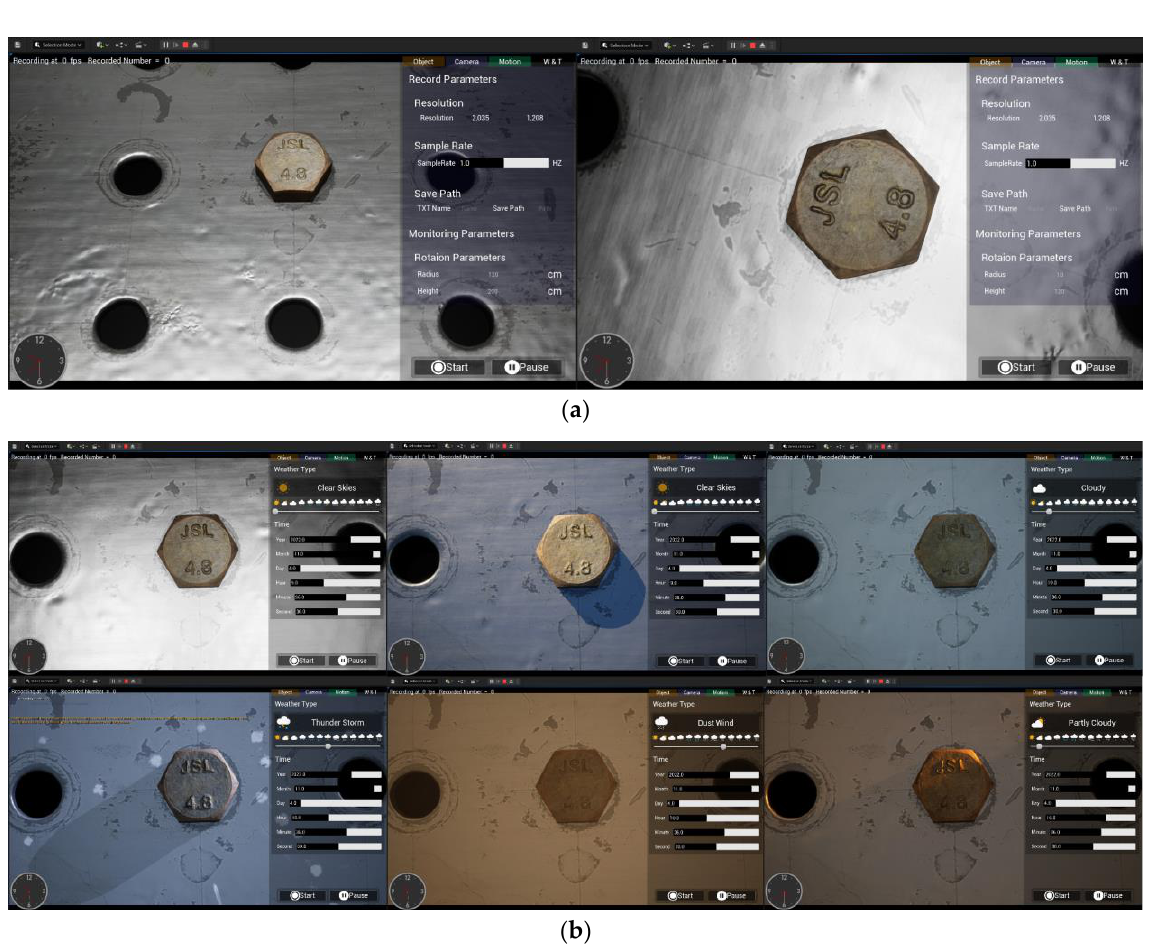
Figure 8. Bolt images generated in the virtual experiment platform. ( a ) Images from different angles; ( b ) Images from different lighting conditions.